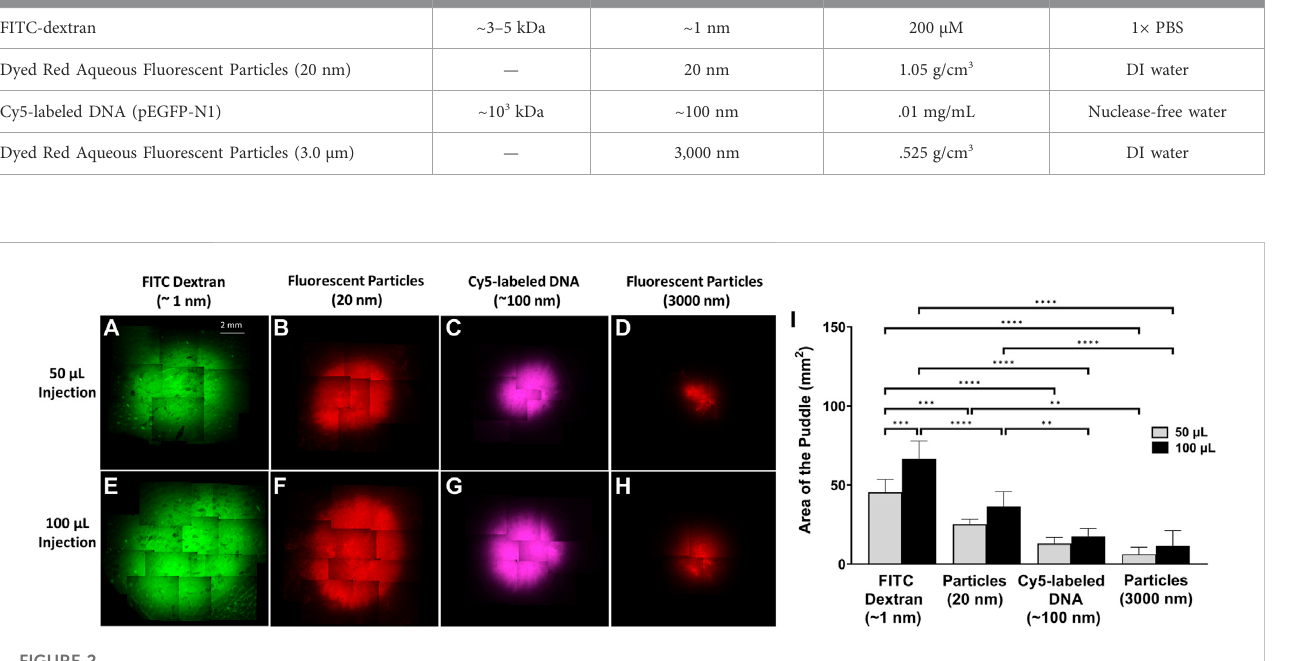
bottom row of Figures 2E – H. Figure 2I shows area quanti fi cation of the puddle area, indicating that a higher injection volume on average leads to a larger puddle area. However, the only statistical difference in the puddle size between the 50 μ L and 100 µL injections occurs for ~1 nm-diameter FITC-dextran. Across materials, the areas of the puddle for FITC-dextran injections (both 50 μ L and 100 µL) were signi fi cantly different when compared with Cy5-labeled DNA and both 20 nm and 3 µm fl uorescent particles ’ puddles. The 50 µL injection puddle size for 20 nm fl uorescent particles was statistically different compared to the 3 µm particles, and the 100 µL injection puddle for 20 nm fl uorescent particles was statistically different compared to the same injection for Cy5-labeled DNA and 3 µm particles.